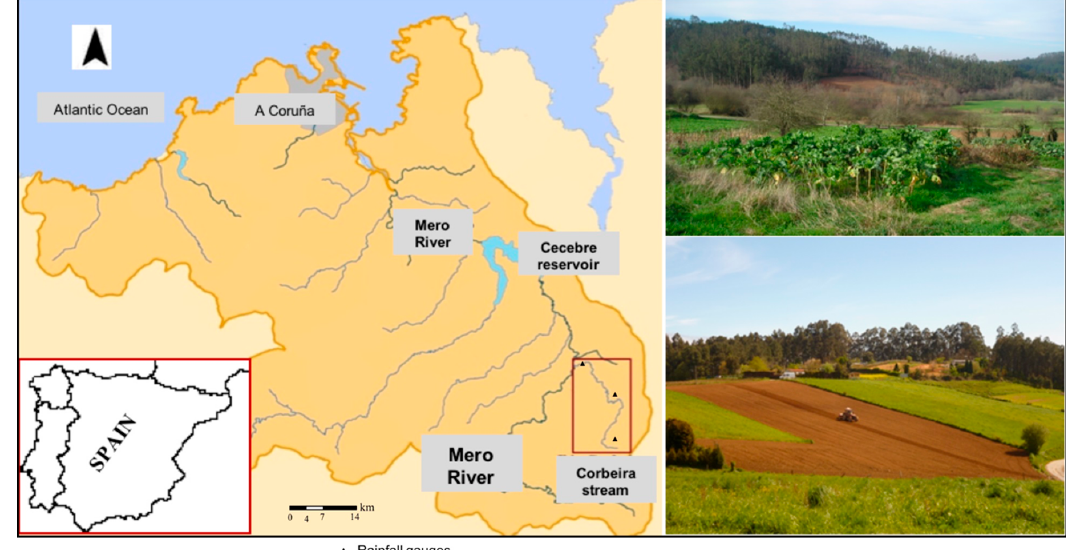
Figure 1. Location of the study area and view of the mosaic of vegetation in agricultural landscapes.